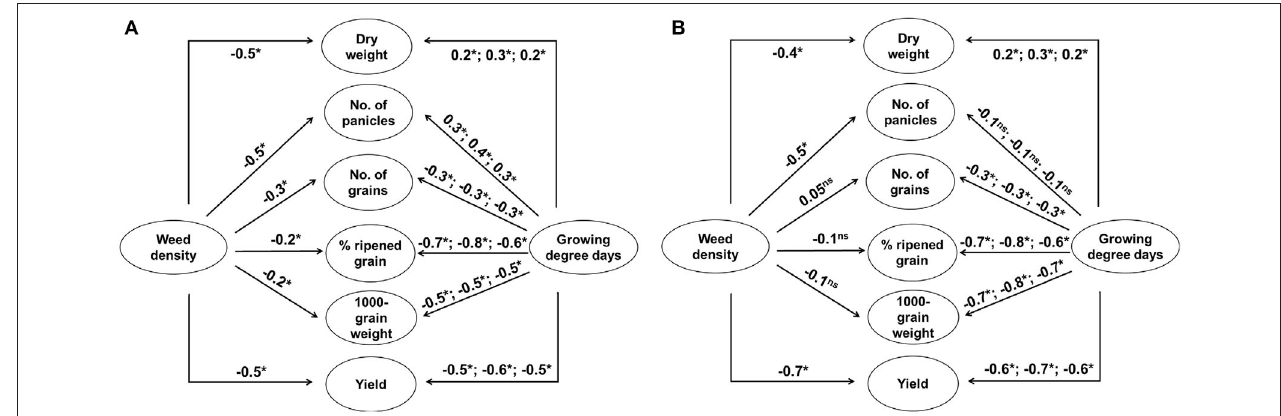
FIGURE 1 | Schematic representations of the correlations among growing degree days (transplanting to tillering, transplanting to flowering, and transplanting to maturity), plant densities of late watergrass (A) and water chestnut (B) , rice yield components (dry weight, number of panicles, number of grains, % ripened grain, 1,000-grain weight), and rice grain yield over 3 years. Significance is indicated as follows: ns , not significant; *, P < 0.05.